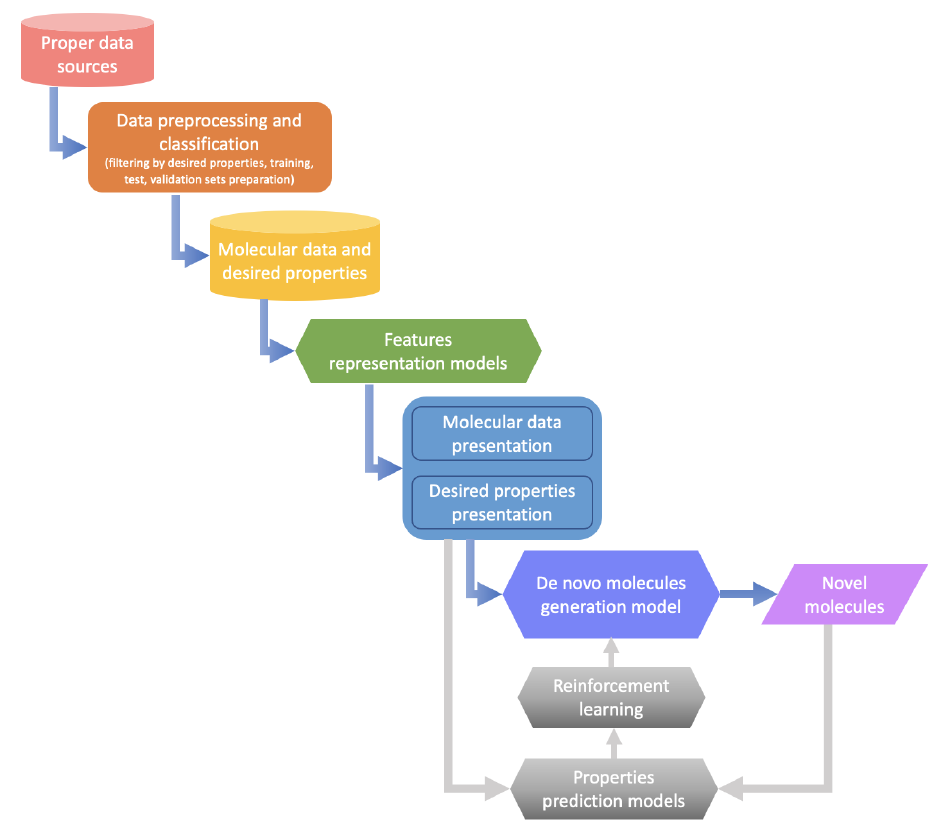
Figure 3. Overview of the machine learning-based de novo drug design procedure, from left-top to right-bottom: appropriate data selection; data filtering and classification; molecular data and de-sired properties storage; feature representation for molecules and properties; molecule generation by machine learning methods; generation model optimization by reinforcement learning strategy and property prediction models; de novo molecules generation.